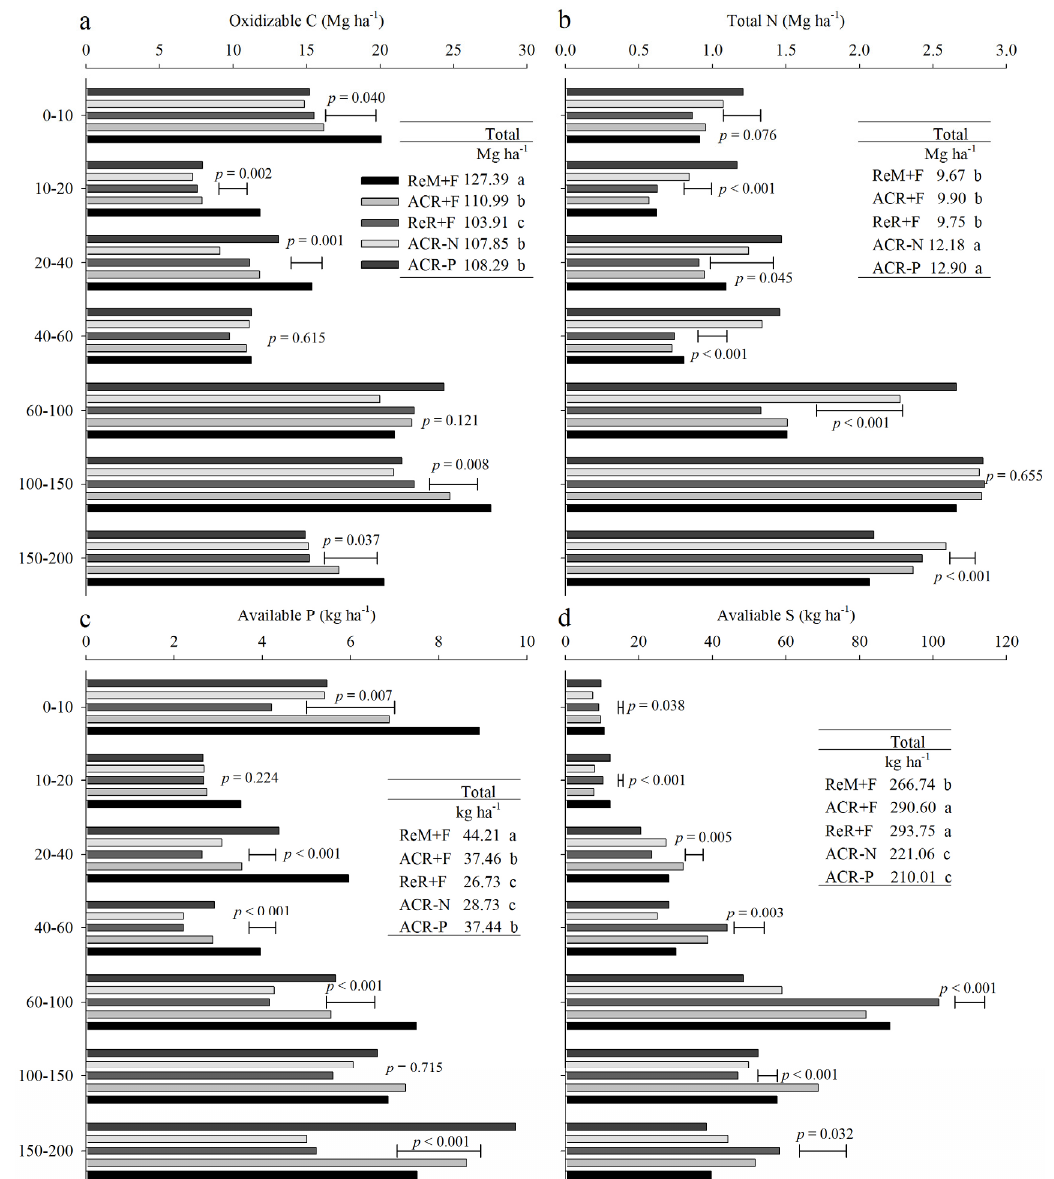
Figure 2. Stocks of oxidizable C ( a ), total N ( b ), available P ( c ) and S ( d ) to 2 m depth in a Eucalyptus plantation under different harvest residue management and fertilizer application strategies. The bars indicate the least significant difference based on the Fisher’s Least Significant Difference (LSD) test at 5% probability, and the values next to the bars show the significance of the F test.